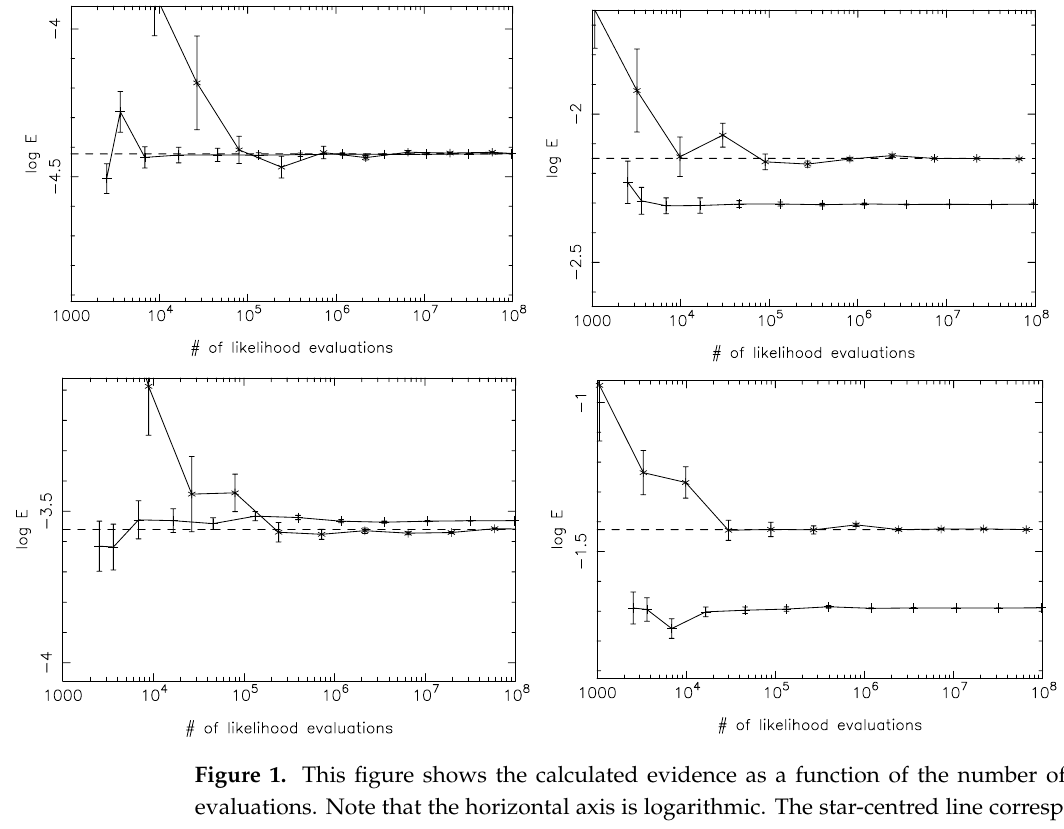
Figure 1. This figure shows the calculated evidence as a function of the number of likelihood evaluations. Note that the horizontal axis is logarithmic. The star-centred line corresponds to the thermodynamic integration. The cross-centred lines are the analytical methods with ( upper panels ) and without ( lower panels ) non-Gaussian corrections applied. The horizontal dashed line is the number obtained by the direct integration. The upper two panels correspond to L g , while the lower two to L ng . The left-hand side panels correspond to wide flat priors of ( − 7,10 ) on both parameters, while the right-hand side to the narrow priors of ( − 2,3 ) on both parameters. The error bars correspond to the dispersion due to the number of likelihood